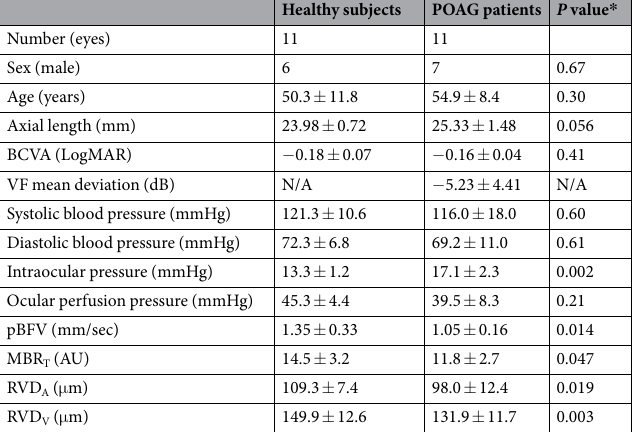
post hoc analysis, comparison with baseline *